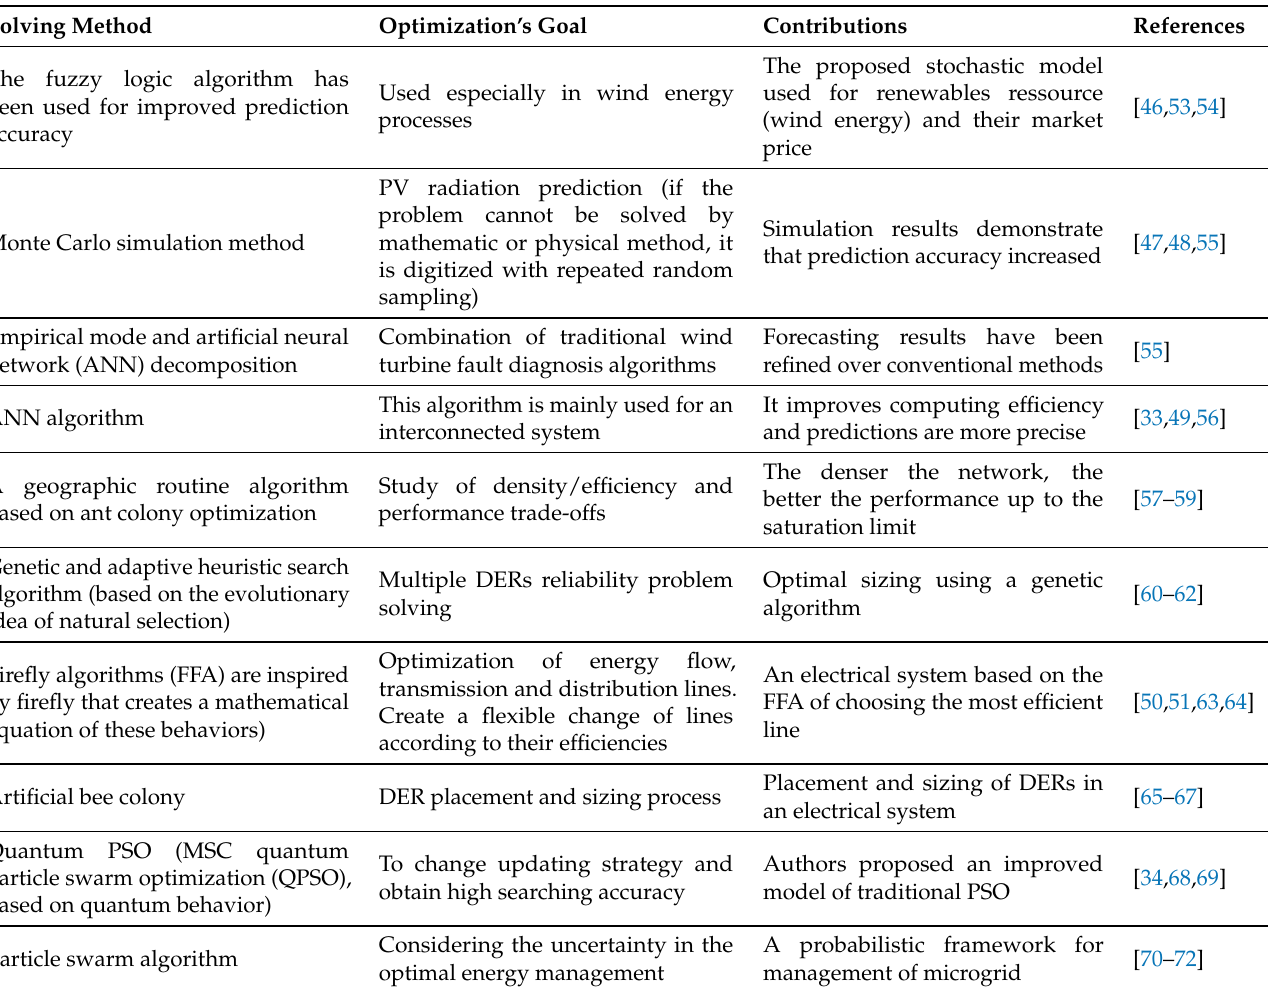
Table 3. Solving